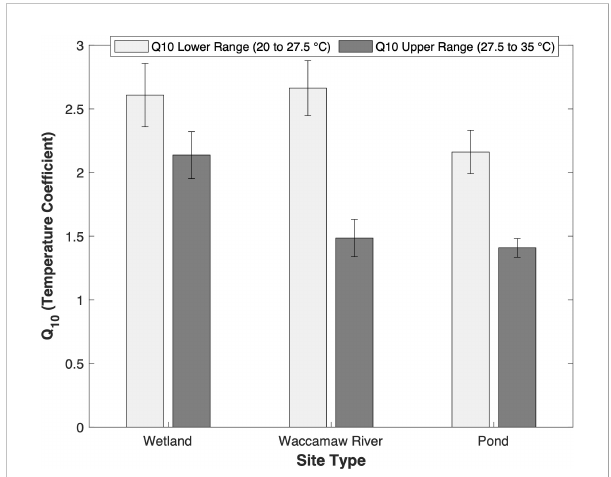
FIGURE 3 Bar graph depicting the Q 10 temperature coef fi cients for each site type (forested wetlands, Waccamaw River, and stormwater detention ponds) at two temperature ranges: Lower range (20 to 27.5°C, light bars) and upper range (27.5 to 35°C, dark bars). Error bars represent standard error across group replication. ANOVA tests yielded no signi fi cant differences for the lower range Q 10 values across sites (p > 0.05), however, for the upper range, wetlands yielded signi fi cantly higher values (p <